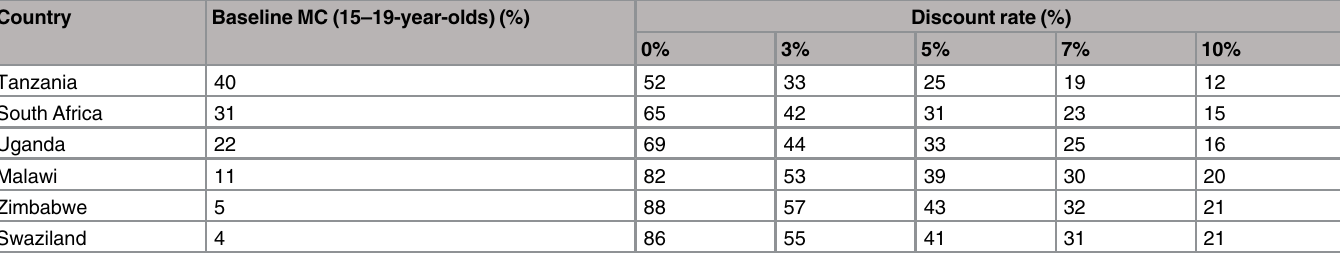
Table 6. Cost Ratios for EIMC and VMMC by